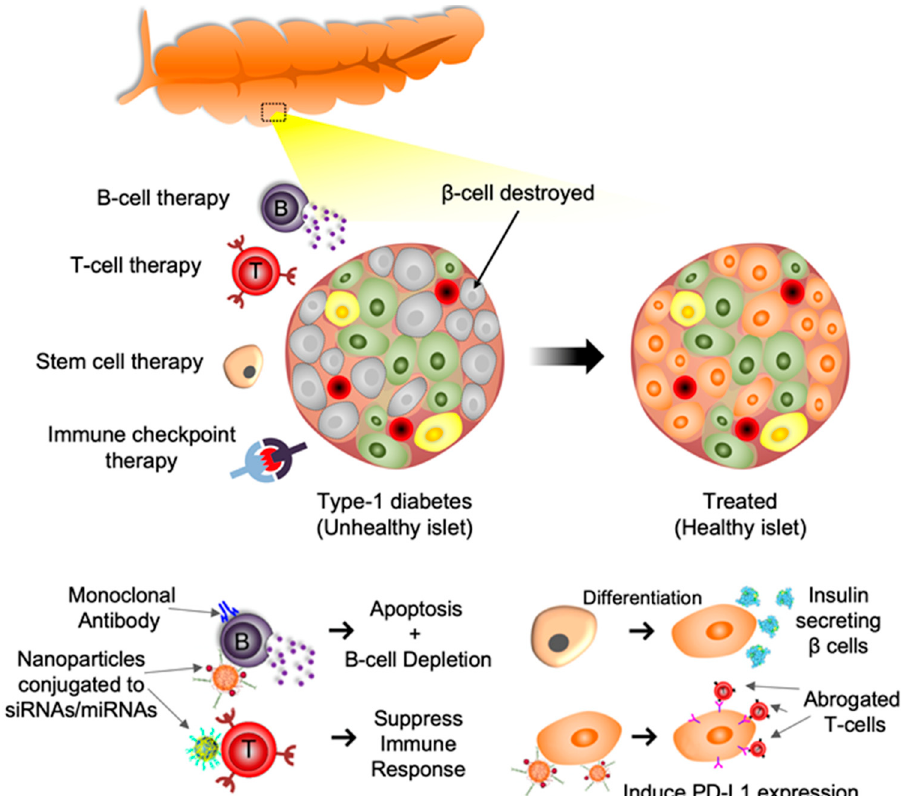
Figure 1. Schematic depiction of immunotherapies for T1D described below. T Cell Therapy: T cells modulated by nanoparticles conjugated to siRNA/miRNA leads to immunosuppression. B Cell Therapy: Modulation of B cells via monoclonal antibodies and/or nanoparticles conjugated to siRNA/miRNA leads to B cell apoptosis and depletion. Immune Checkpoint therapy: Nanoparticles conjugated to siRNA/miRNA induces PD-L1/CTLA4 expression resulting in abrogation of proximal T cells. Stem Cell Therapy: Differentiated stem cells transform into insulin producing beta cells.